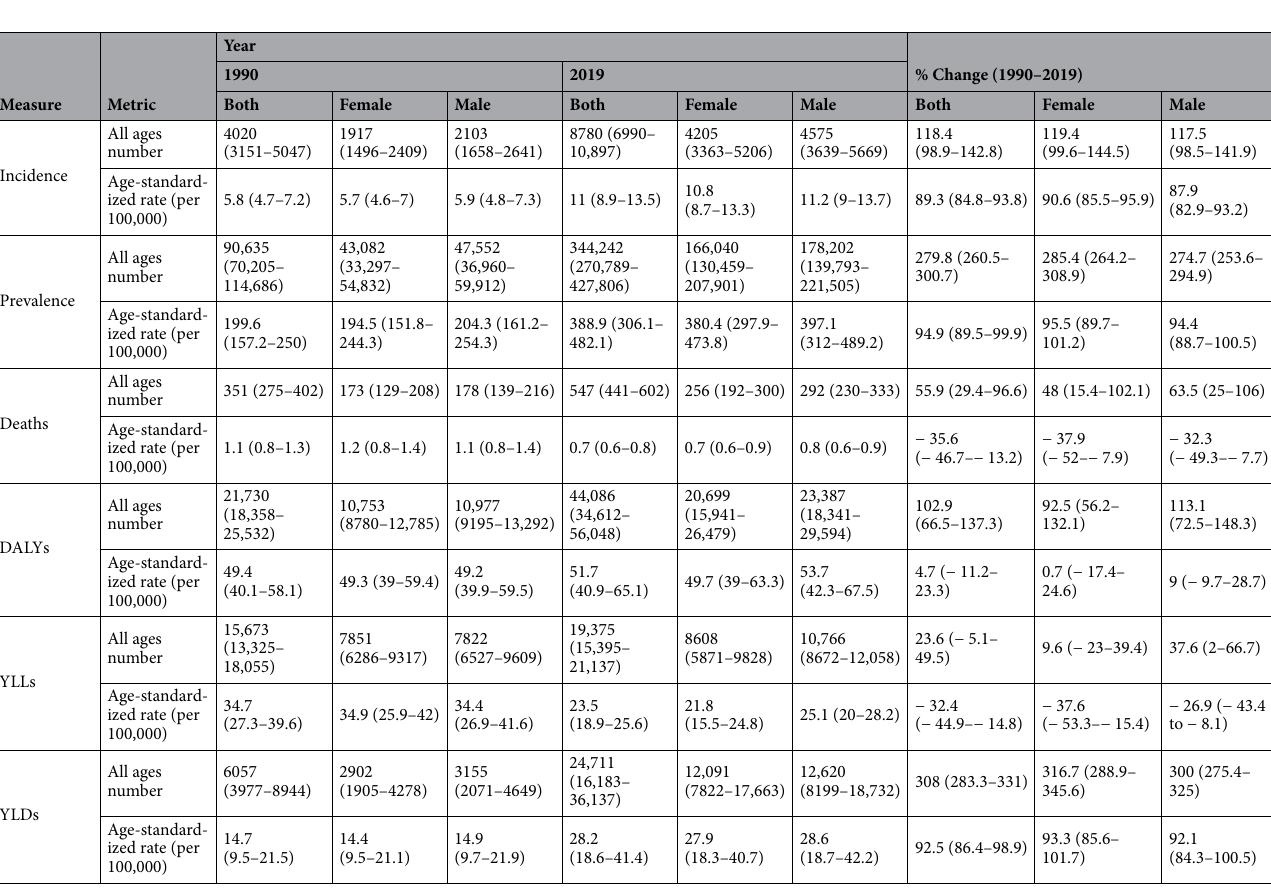
Table 1. All ages number and age-standardized rate (per 100,000), Iran. Data in parentheses are 95% UIs.